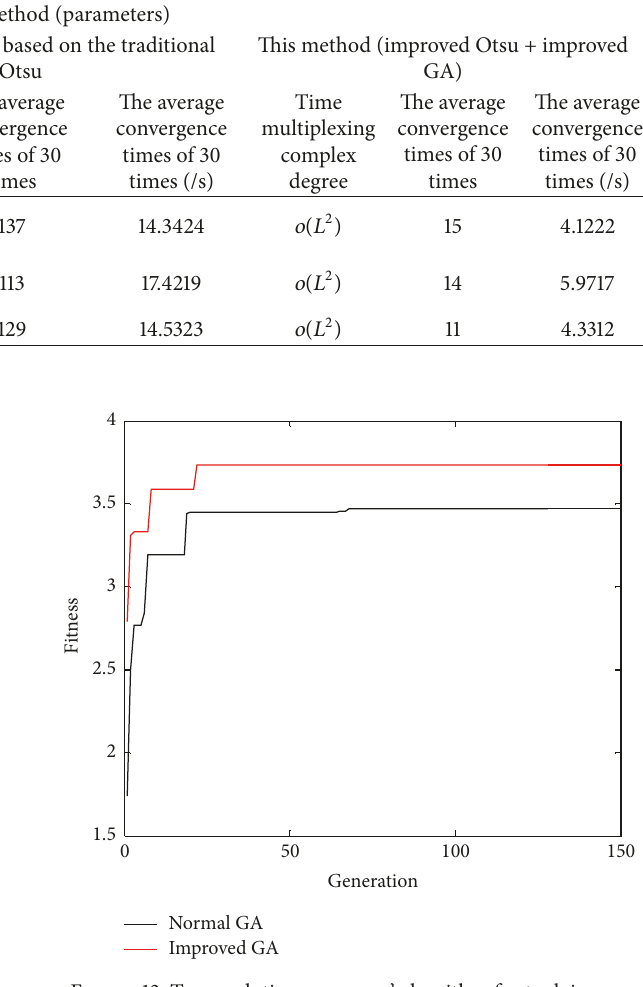
Figure 13: Two evolutionary curves’ algorithm for tank